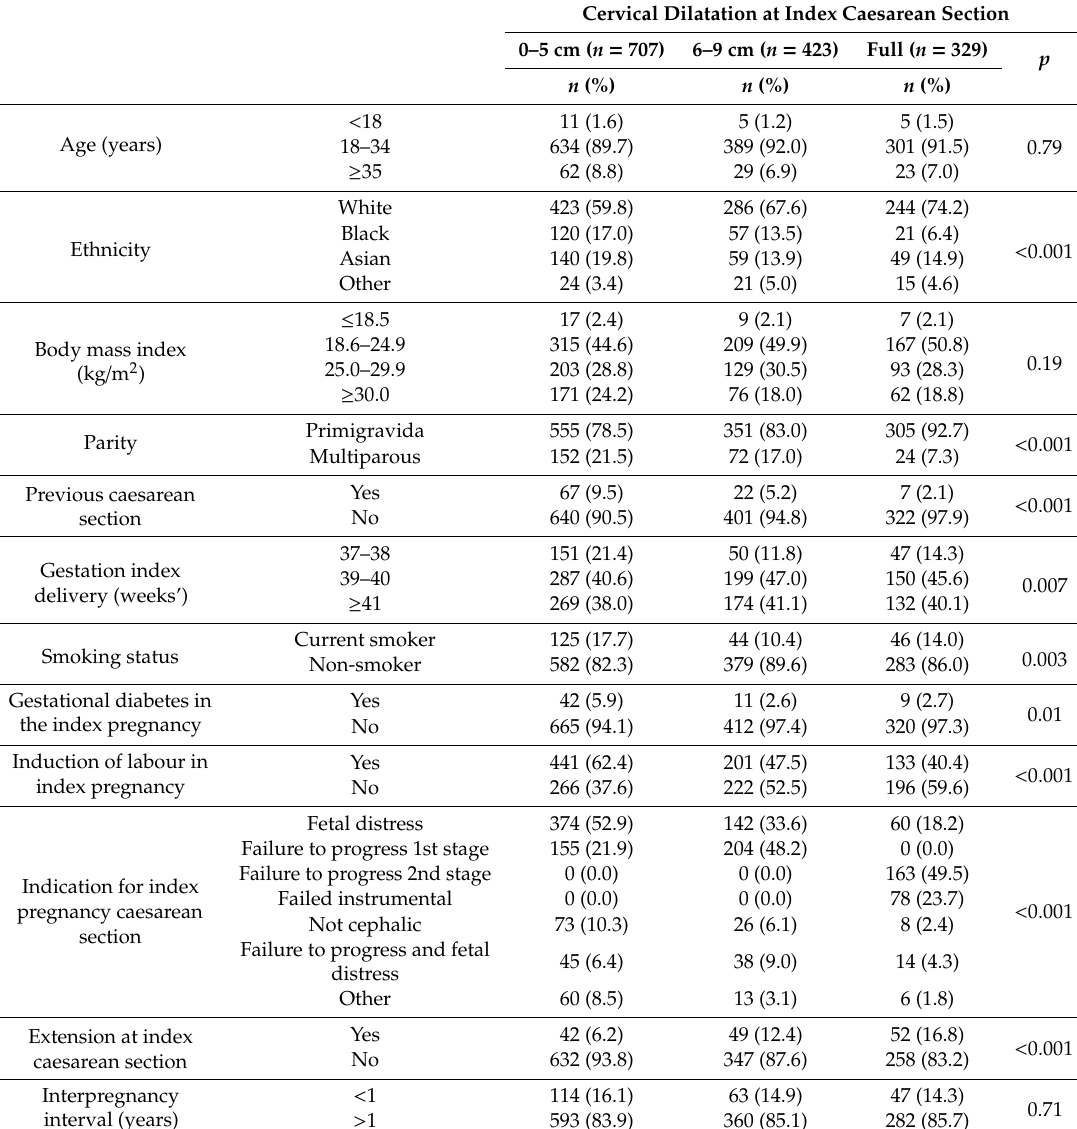
Table 1. Baseline characteristics of the study